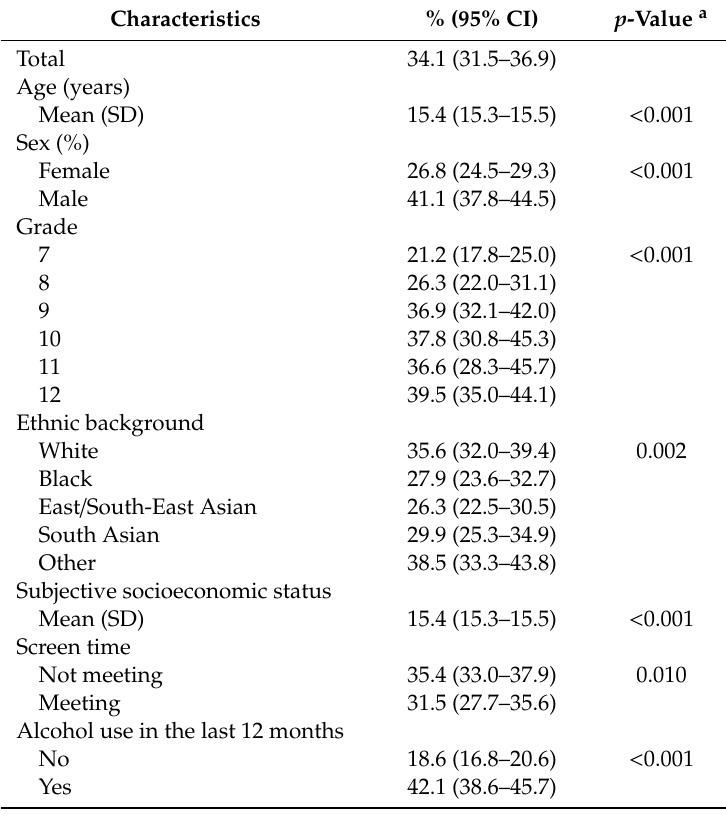
Bivariate associations between energy drink consumption in the past 12 months, sociodemographic, and behavioral characteristics among adolescents.